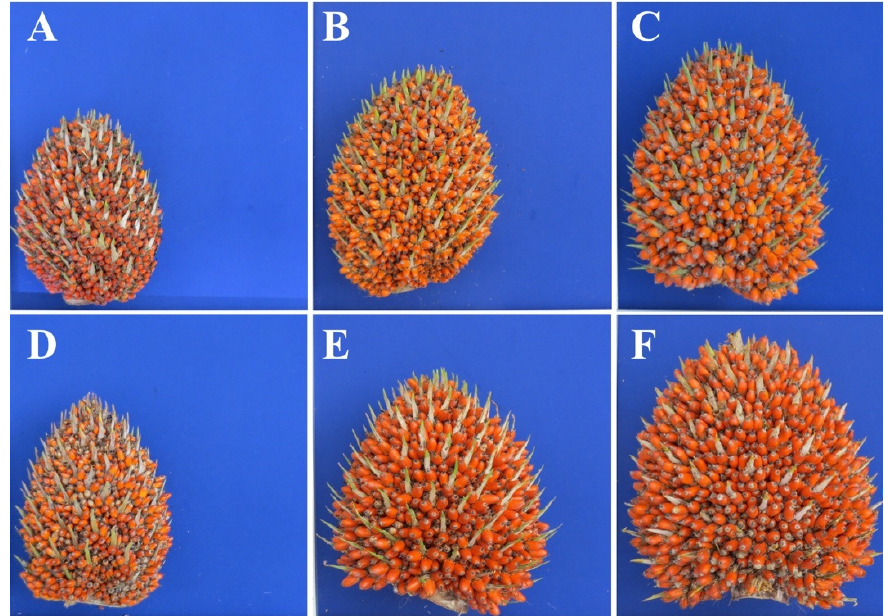
Figure 3. Bunches formed by 600 mg L − 1 or 1200 mg L − 1 NAA applications in OxG hybrids (Coari x La Mé). Bunch conformation improved with multiple hormone applications. Bunches were composed only of oily parthenocarpic fruits. The pictures are from representative bunches selected from treatments started at different phenological stages. ( A ) A dose of 600 mg L − 1 NAA applied once. ( B ) A dose of 600 mg L − 1 NAA applied twice. ( C ) A dose of 600 mg L − 1 NAA applied three times. ( D ) A dose of 1200 mg L − 1 NAA applied once. ( E ) A dose of 1200 mg L − 1 NAA applied twice. ( F ) A dose of 1200 mg L − 1 NAA applied three times.